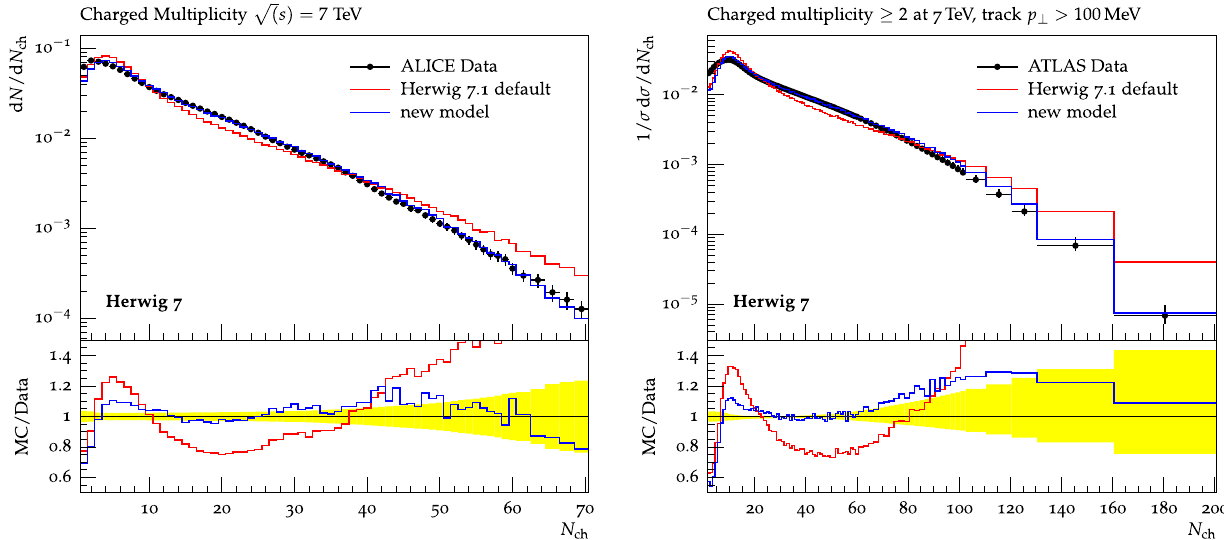
Fig. 6 Multiplicity distributions as measured by ALICE for the central rapidity region | η | < 1 up to N ch = 70 [24] and ATLAS for | η | < 2 . 4 up to N ch = 200 for all particles with p ⊥ > 100MeV [28]. We compare the old default colour reconnection model with the new baryonic colour reconnection model Table 2 Results of the parameter values from the tuning procedure that resulted in the smallest χ 2 / N dof value for energy compared with the default tune from Herwig